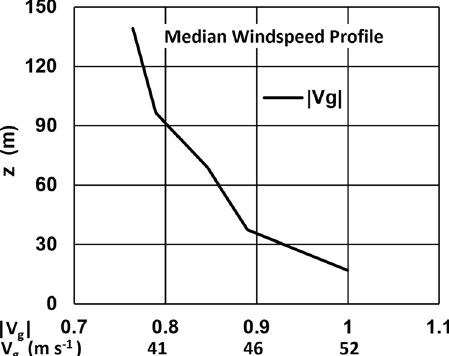
Fig. 4 DOW-observed tornado windspeed pro fi le. Median |V g | pro fi le based on DOW observations, and example of pro fi le calculated